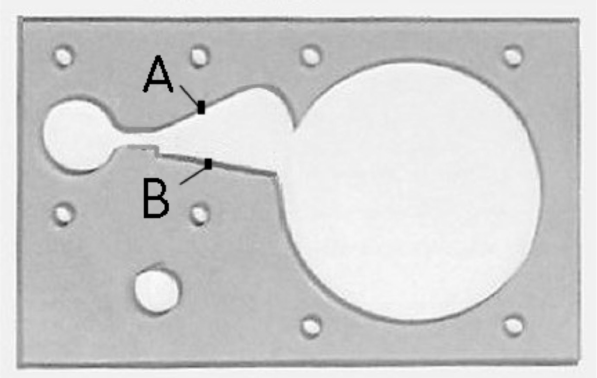
Figure 10. Photograph of one of the oscillator main plates with which were run the laboratory tests.